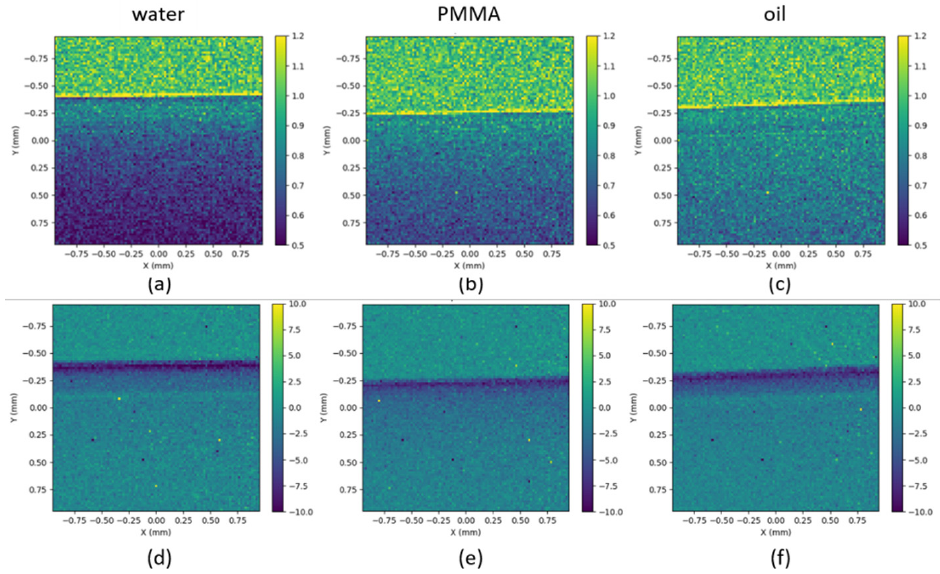
Figure 16. I/I 0 map for the Hartmann mask for ( a ) the capillary with water, ( b ) the Poly(methyl methacrylate) (PMMA) and ( c ) the capillary with oil. An intensity ratio of one corresponds to the air (at the top of the three maps). Deflection (in µrad) maps for ( d ) the capillary with water, ( e ) the PMMA and ( f ) the capillary with oil. Sample magnification of 3.08. X and Y axis are in mm.